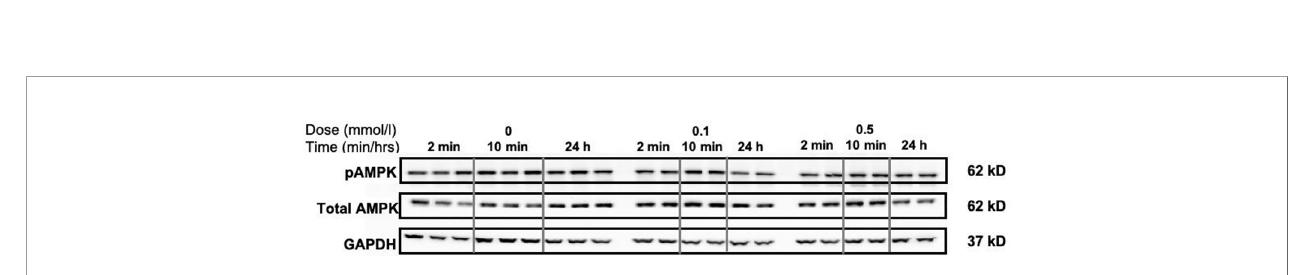
FIGURE 2 | Dose-effect of SA on exogenous and endogenous fat oxidation in HSkMC. (A) Complete ( 14 CO 2 ) and (B) incomplete (ASM) 14 C-palmitate exogenous oxidation (5 independent experiments) was measured following 20h incubation without (0 mmol/l) or with (0.1-5 mmol/l) SA. In addition, following 24h pre-incubation with 14 C-palmitate, (C) complete ( 14 CO 2 ) and (D) incomplete (ASM) 14 C-palmitate endogenous oxidation (4 independent experiments) was measured following 20h incubation without (0 mmol/l) or with (0.1-5 mmol/l) SA. Data expressed as mean and standard deviation and expressed as relative to control treated cells. P value corresponds to Kruskal-Wallis test. Post-hoc test signi fi cance is compared to control (0 mmol/l) indicated as asterisk (*) when P < 0.05.